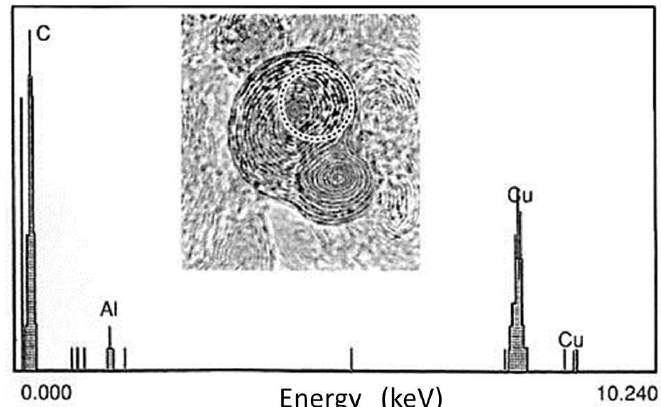
Figure 13. EDS analysis of the area inside the dotted circle in the nanostructure shown in Figure 11. The electron probe size was 7 nm in diameter. An Al peak was detected, indicating the possibility of intercalation, whereas the Cu peaks came from the Cu grid of the membrane [10].